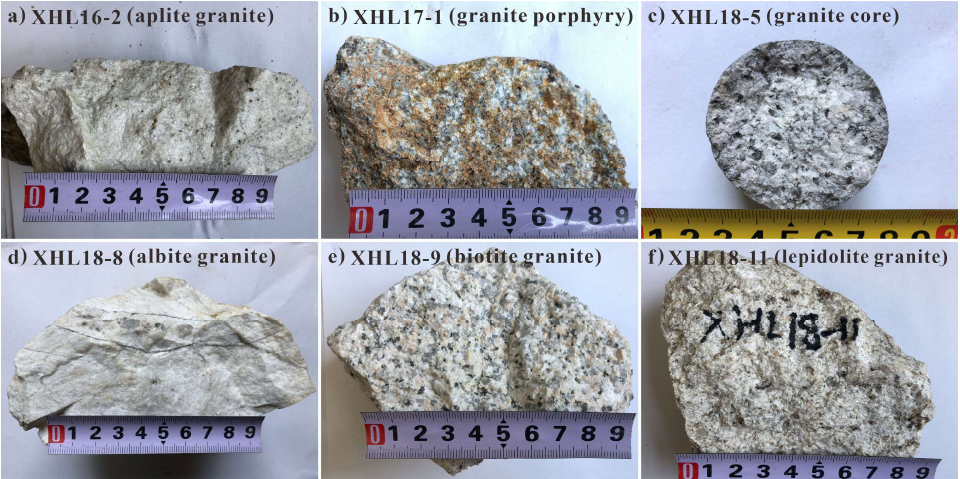
Figure 3. The photos of hand specimens of typical samples of the Xianghualing granitic rocks: ( a ) aplite (XHL16-2); ( b ) granite porphyry (XHL17-1); ( c ) granite core (XHL18-5); ( d ) albite granite (XHL18-8); ( e ) biotite granite (XHL18-9); ( f ) lepidolite granite (XHL18-11). Photomicrographs of typical samples of Xianghualing granitic rocks are shown in Figure 4a–i, including granite porphyry (XHL17-1, Figure 4a,b), granite (XHL18-5, Figure 4c–d), and biotite granite (XHL18-9, Figure 4e,f).